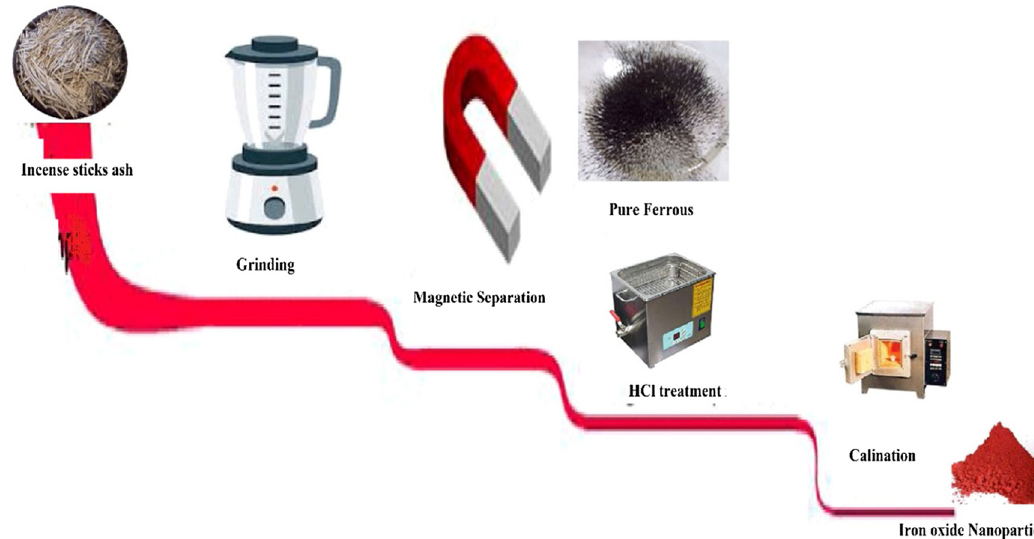
Figure 20: Synthesis of iron oxide NPs. Copied with permission from ref. [ 253 ] ; Elsevier,